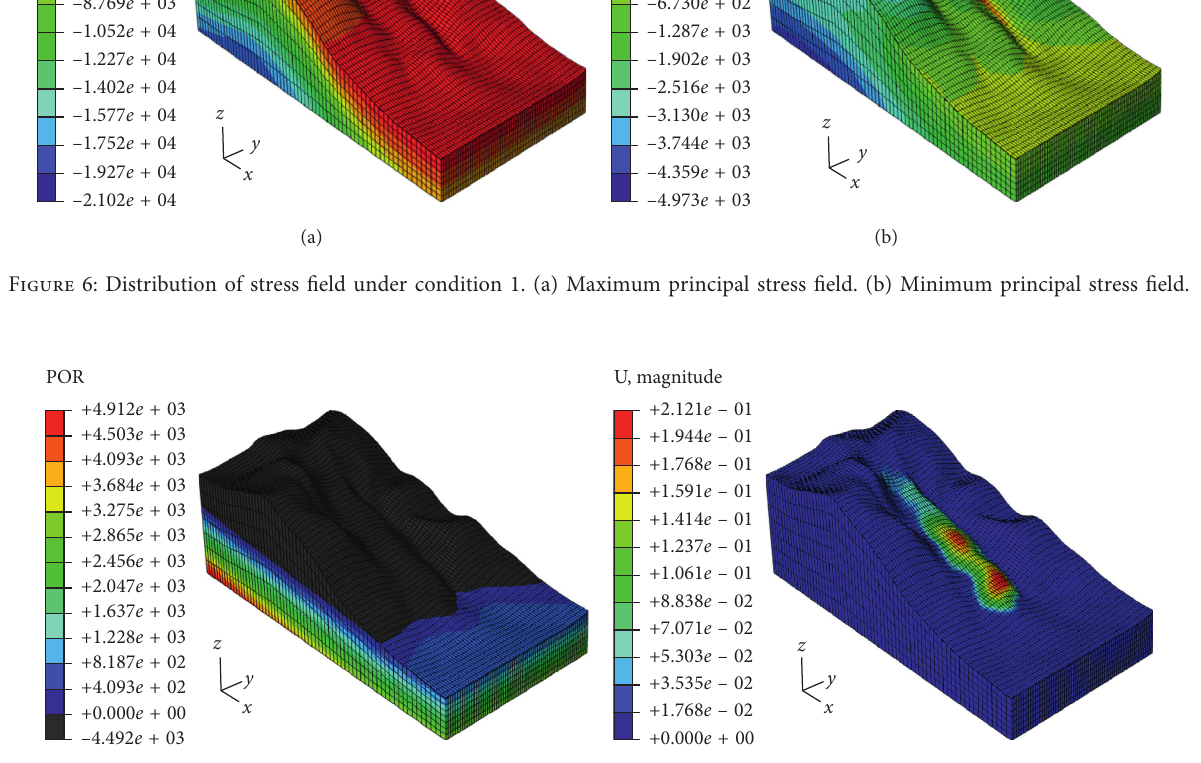
Figure 7: Deformation distribution diagram under condition 1. (a) Pore pressure distribution. (b) Displacement distribution.